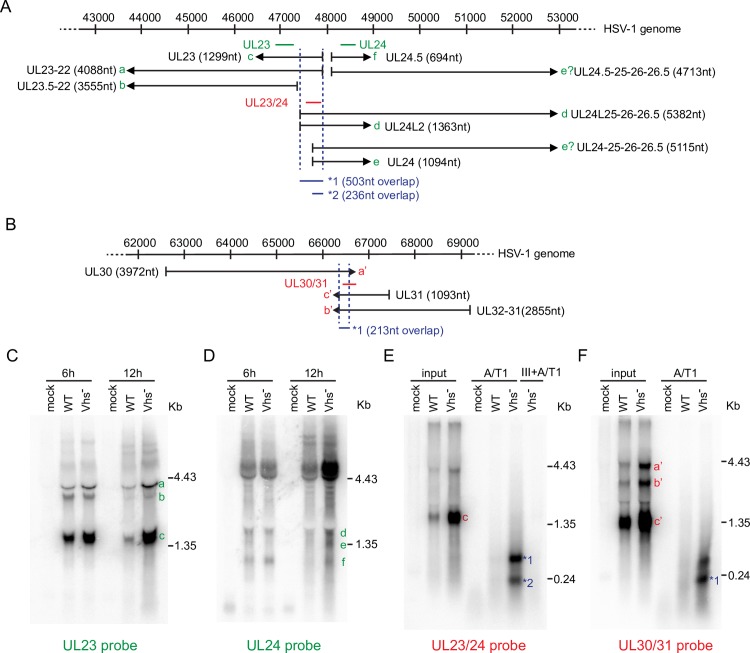
Effects of vhs on the levels of partially complementary viral transcripts and dsRNA levels.A and B) Diagram of the UL23/UL24 (A) and UL30/UL31 (B) regions of the HSV-1 genome, with the transcripts detected by Tombacz et al. 2017 and earlier studies depicted. The probes used for northern blots analysis are diagrammed. Coordinates are from the HSV-1 strain 17 reference genome (X14112). C and D) HeLa cells were infected with HSV-1 (KOS) WT and Vhs- for 6 or 12 hours at an MOI of 10. Equal amounts of total RNA were analyzed by Northern blot with probes specific for either the UL23 (C) or UL24 (D) transcripts. Results shown are representative of 3 independent experiments. E) Detection of UL23/UL24 duplex RNA. HeLa cells were infected with HSV-1 (KOS) WT and Vhs- for 12 hours at an MOI of 10. Total RNA was extracted and digested with RNaseA/T1 (high salt buffer) or RNaseIII followed by RNaseA/T1. Undigested input (1/10) and digested samples were analyzed by Northern blot with a probe specific for the predicted overlap between the UL23 and UL24 transcripts. F) Detection of UL30/UL31 duplexRNA. The experiment was performed as in E) but with a probe specific for the predicted overlap between UL30 and UL31 transcripts. Results shown in E) and F) are representative of 4 independent experiments each.